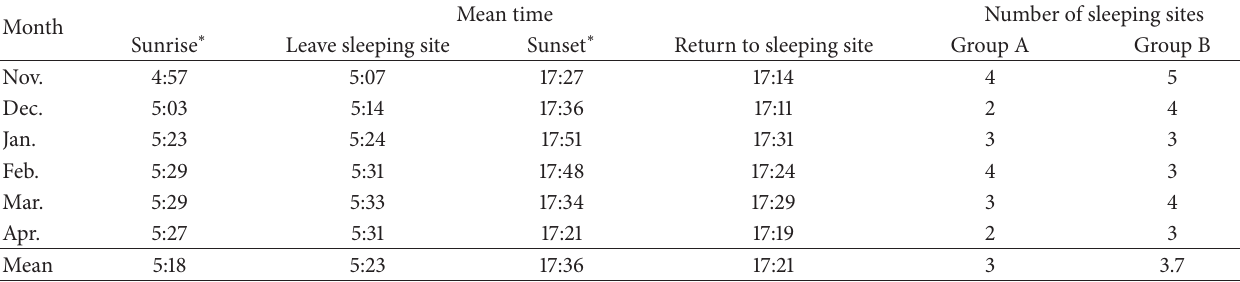
Table 3: Sleeping cycle and number of sleeping sites used monthly by common marmosets in the study period. Mean time Number of sleeping sites Month Sunrise ∗ Leave sleeping site Sunset ∗